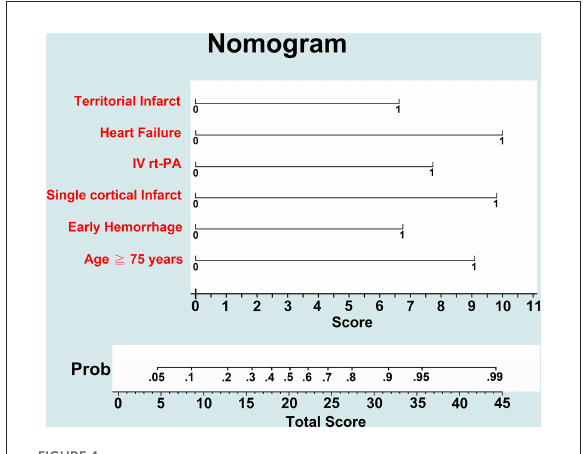
FIGURE4 Nomogram of the prediction model for newly detected